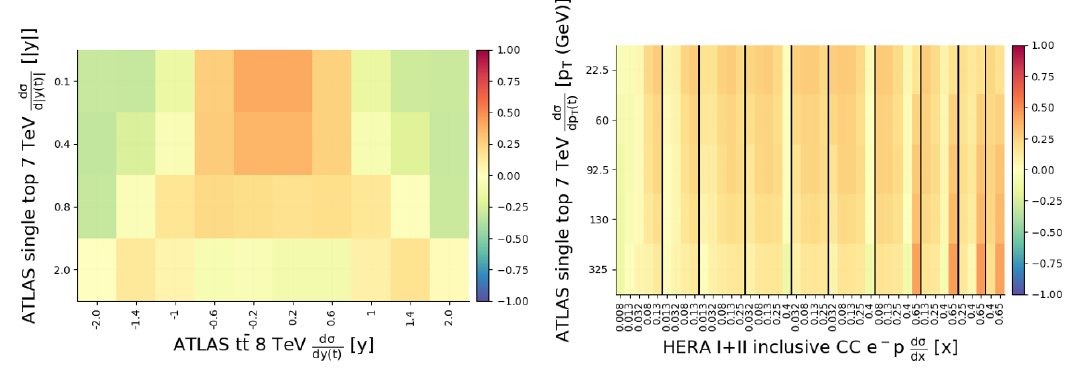
Figure 13 . (Left) The correlations between bins of the ATLAS 8 TeV tt dataset, which is binned in the rapidity of the top quark, and the ATLAS 7 TeV single top-quark absolute rapidity distribution. (Right) The correlations between the HERA combination e (cid:0) p dataset and the absolute ATLAS 7 TeV single top-quark transverse momentum distribution. The HERA data is binned in Q 2 and then within these bins, it is binned in Bjorken- x . The vertical black lines indicate the edges of the Q 2 bins. The lowest of these bins is for Q 2 = 300 GeV 2 and the highest is for Q 2 = 30 (cid:2) 10 3 GeV 2 . Both plots have been produced using theoretical predictions at NNLO in QCD with the NNPDF31 nnlo as 0118 PDF set and Q = m t = 172 : 5 GeV. The colour bar indicates the correspondence between (cid:26) and the colours in the